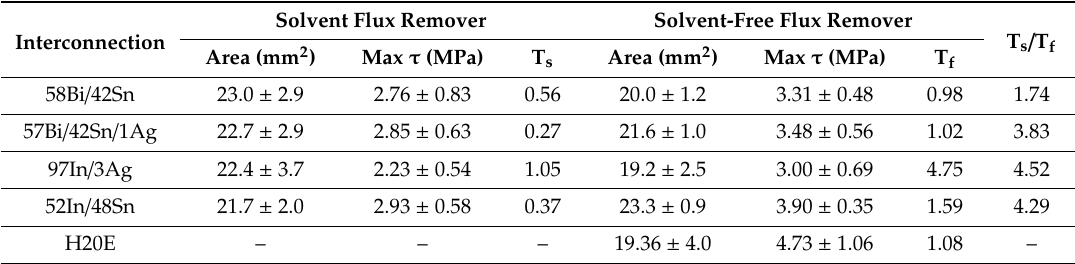
Table 2. Wire bond pull testing results for silver HPS-FG57B conductive ink.